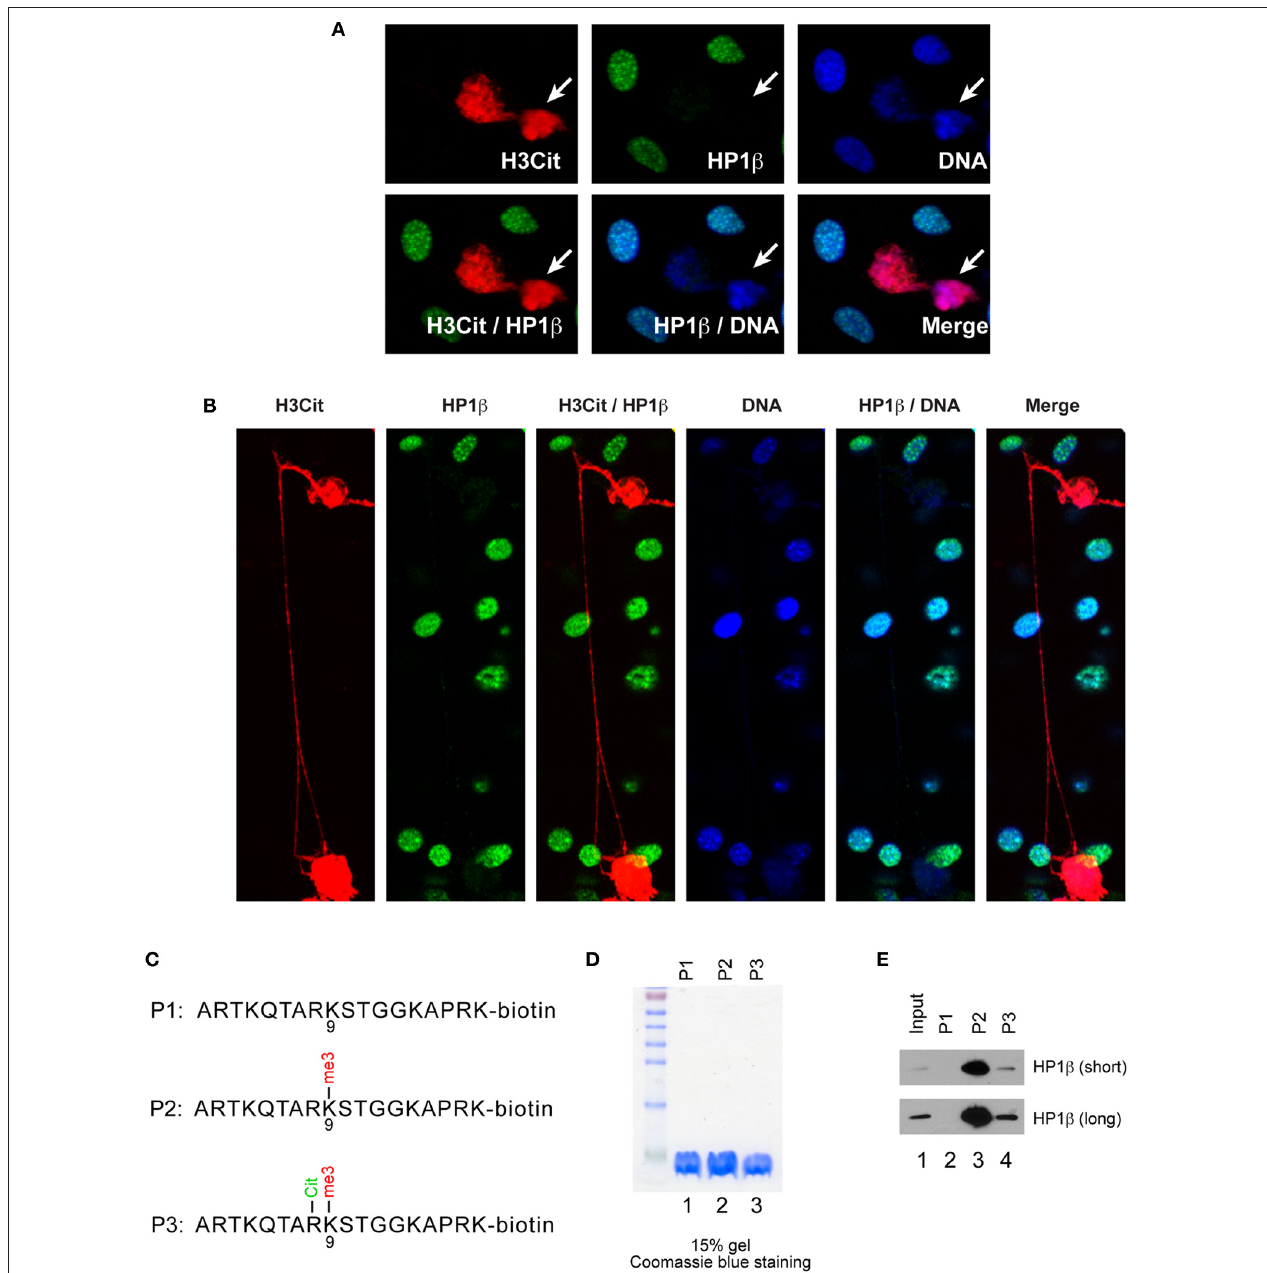
FIGURE 5 | Forced HA-PAD4 expression induced heterochromatin decondensation and HP1 β dissociation in NIH 3T3 cells. (A) Immunostaining assays of H3Cit and HP1 β in NIH 3T3 cells after forced HA-PAD4 expression. Arrows denote a cell with an increase in H3Cit, a loss of HP1 β and the organization of distinct heterochromatic loci, a distinct feature of these cells. (B) Immunostaining with H3Cit and HP1 β in NIH 3T3 cells with forced HA-PAD4 expression. Note the extreme chromatin